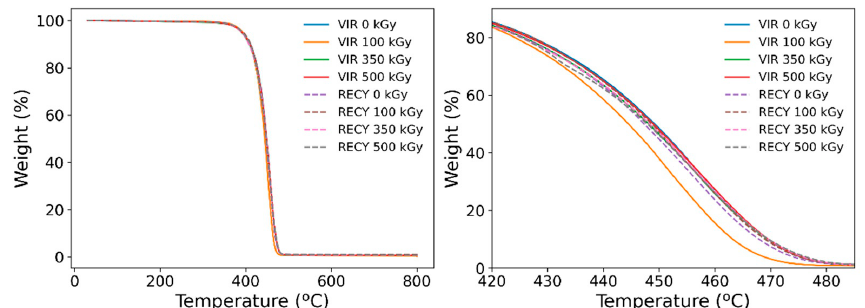
Figure 14. TGA scans for all samples. Left: whole analysis temperature range. Right: closeup of the intermediate range. Table 5. Main characteristics of the TGA analysis.